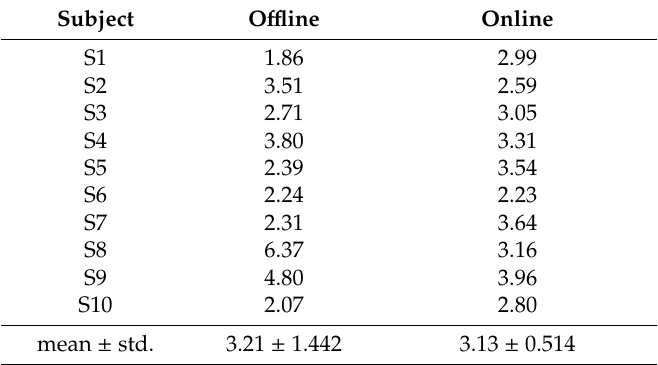
Table 4. O ffl ine and online information transfer rate (ITR) (bits /